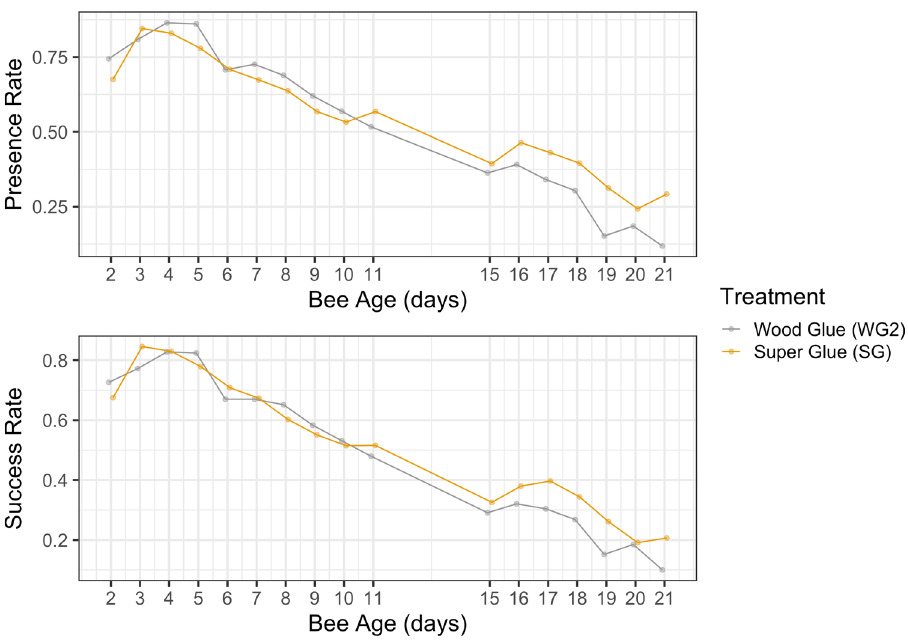
Figure 3. Presence and success of nurses on the days following introduction to the three observation hives. Bees were introduced at 1 day